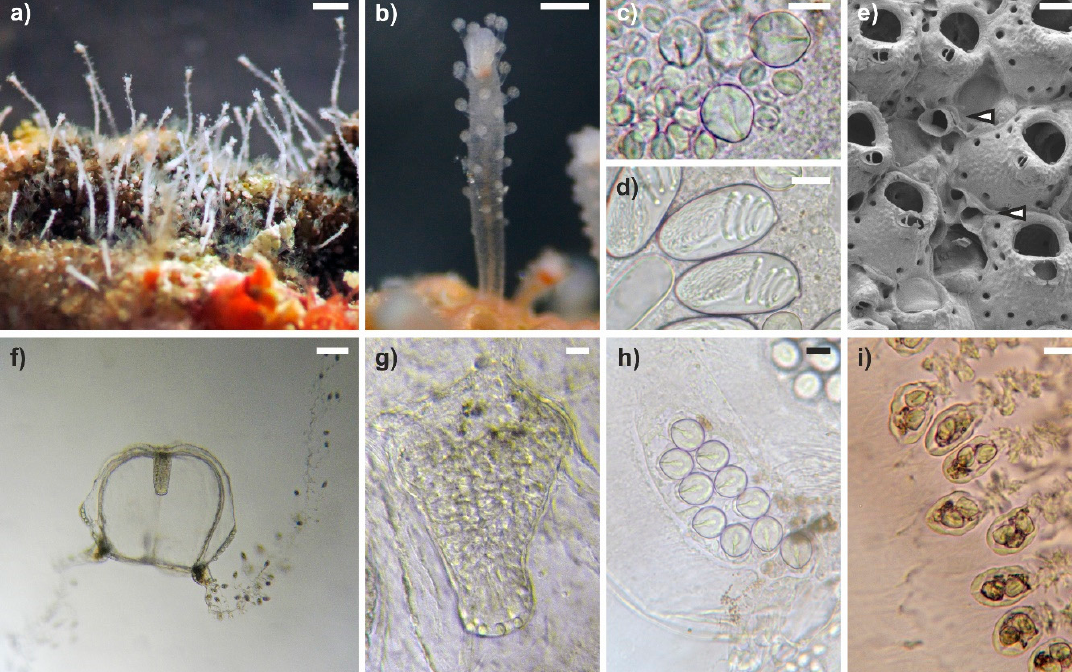
Figure 1. Zanclea divergens . ( a ) Colony associated with Celleporaria vermiformis ; ( b ) close-up of a polyp;